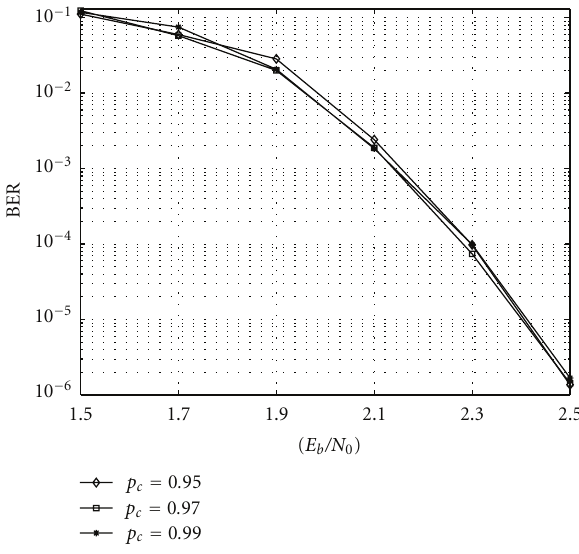
Figure 7: E ff ect of the crossover probability for (16, 11, 4) 3 at 12th iteration on IGAD1.